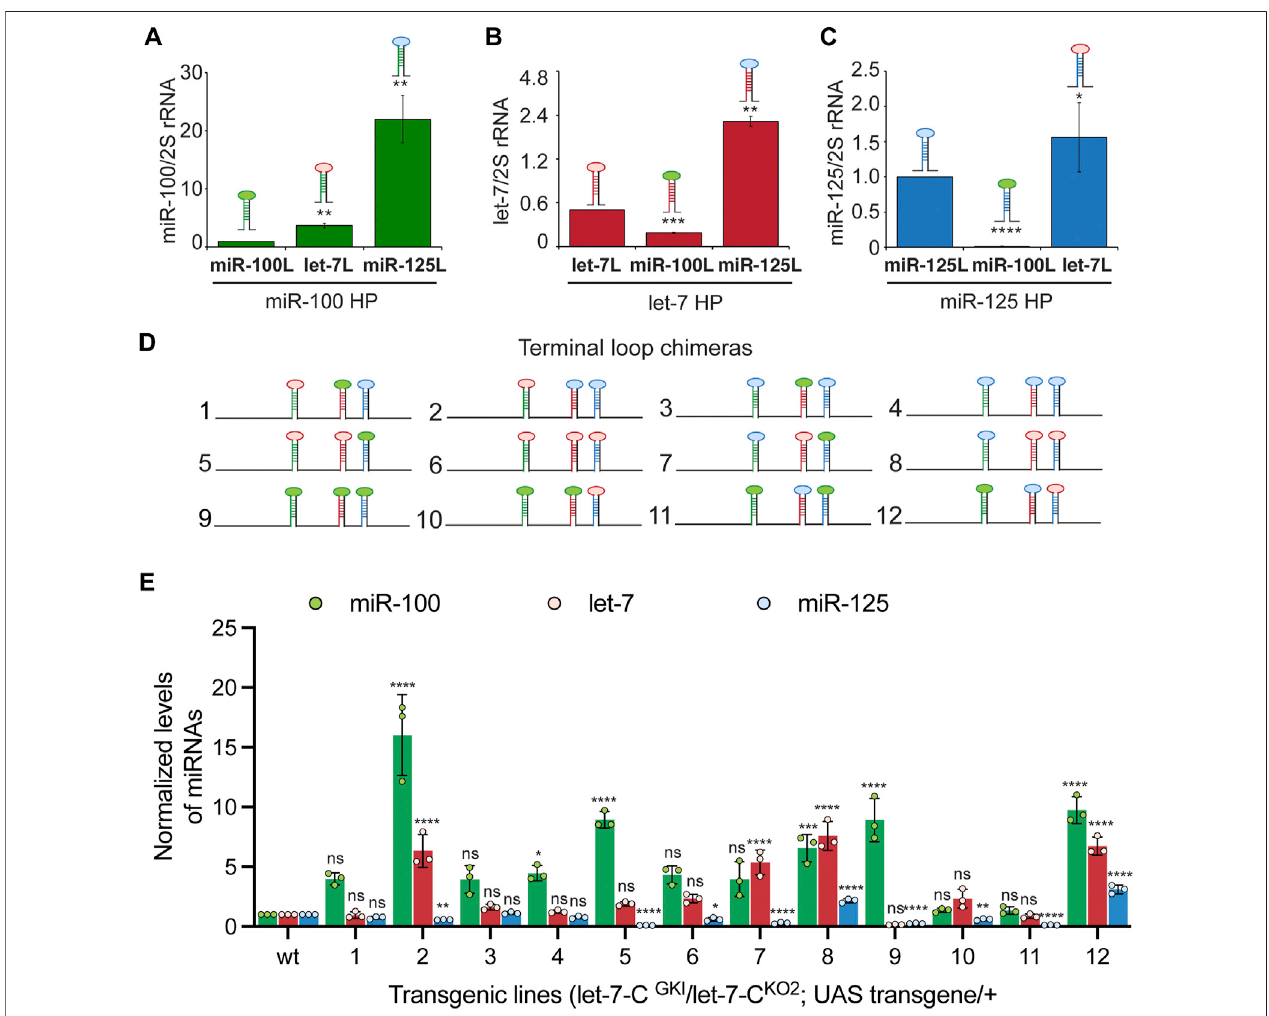
FIGURE 6 | Terminal loops are critical determinants for expression of let-7-Complex miRNAs. (A) Expression of miR-100 in transgenic lines expressing UAS pri - miR-100, UAS pri-miR-100Hlet-7TL, and UAS pri-miR-100HmiR-125TL under the control of let-7-C Gal4 knock-in driver ( G4KI ) as determined by Taqman miRNA assays. Data are represented as mean ± SD, n = 3. p -value calculated by ordinary one-way ANOVA is 2.33E-04. (B) Expression of let-7 in transgenic lines expressing UAS pri - let-7, UASpri-let-7HmiR-100TL,andUASpri-let-7HmiR-125TL underthecontrolof let-7-C Gal4knock-indriver( G4KI )asdetermined byTaqman miRNA assays. Data are represented as mean ± SD, n = 3. p -value calculated by ordinary one-way ANOVA is 3.96E-08. (C) Expression of miR-125 in transgenic lines expressing UAS pri-miR-125, UAS pri-miR-125HmiR-100TL, and UAS pri-miR-125Hlet-7TL under the control of let-7-C Gal4 knock-in driver ( G4KI ) as determined by Taqman miRNA assays. Data are represented as mean ± SD, n = 3. p -value calculated by ordinary one-way ANOVA is 1.95E-03. (D) Schematic representation of UAS let-7-Cchimerasthataredescribedinpanels (E) . (E) Expressionof miR-100 (greenbar), let-7 (redbar),and miR-125 (bluebar)intransgeniclinesexpressing UASlet-7-C cDNAwildtypeandchimerasunderthecontrolof let-7-C Gal4knock-indriver( G4KI )asdeterminedbyTaqmanmiRNAassays.TotalRNAwasextractedfromadult fl ies thatwereinatransheterozygote let-7-C nullmutantofthefollowinggenotype: let-7-C GKI / let-7-C KO2 ;UAStransgene/+ .2SrRNAwasusedasacontrolfornormalization. Dataarerepresentedasmean±SD, n =3. p -valuecalculatedbyordinaryone-wayANOVAformiR-100is2.20E-12;forlet-7is4.60E-14;andformiR-125is < 1.00E-15. Adjusted p -values after applying Bonferroni ’ scorrection are represented inthe fi gure panel and weused an α level of 0.05 toassess statistical signi fi cance.Genotype